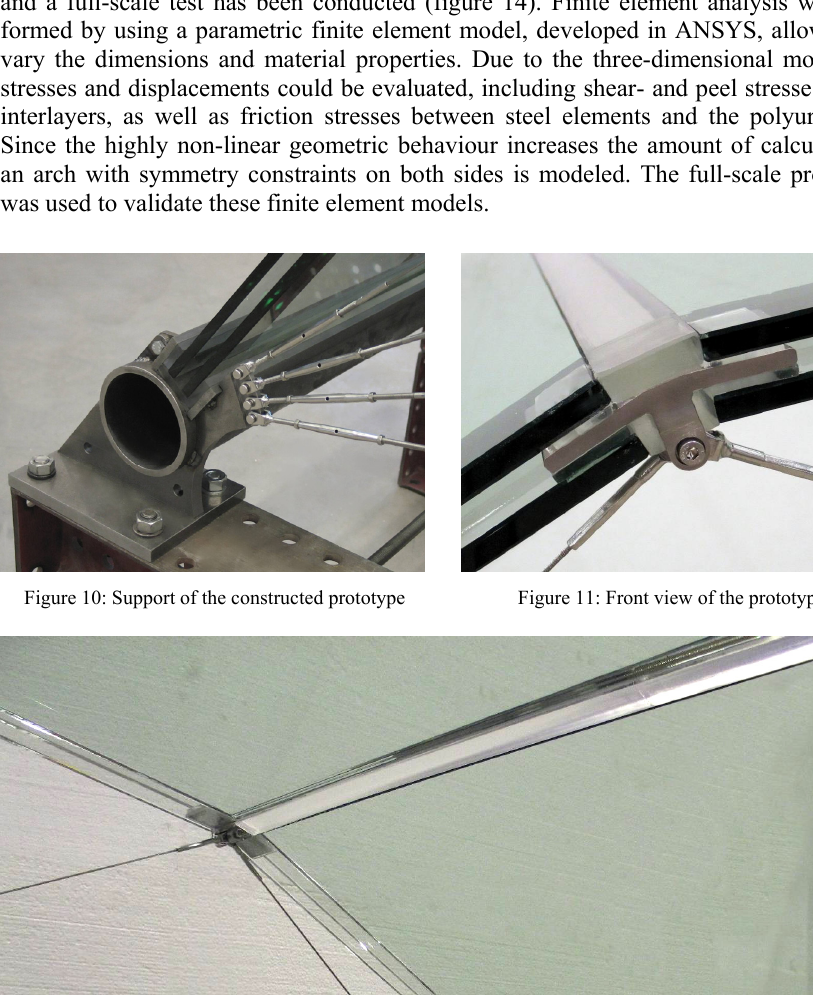
Figure 12: View from underneath the prototype: Full transparent